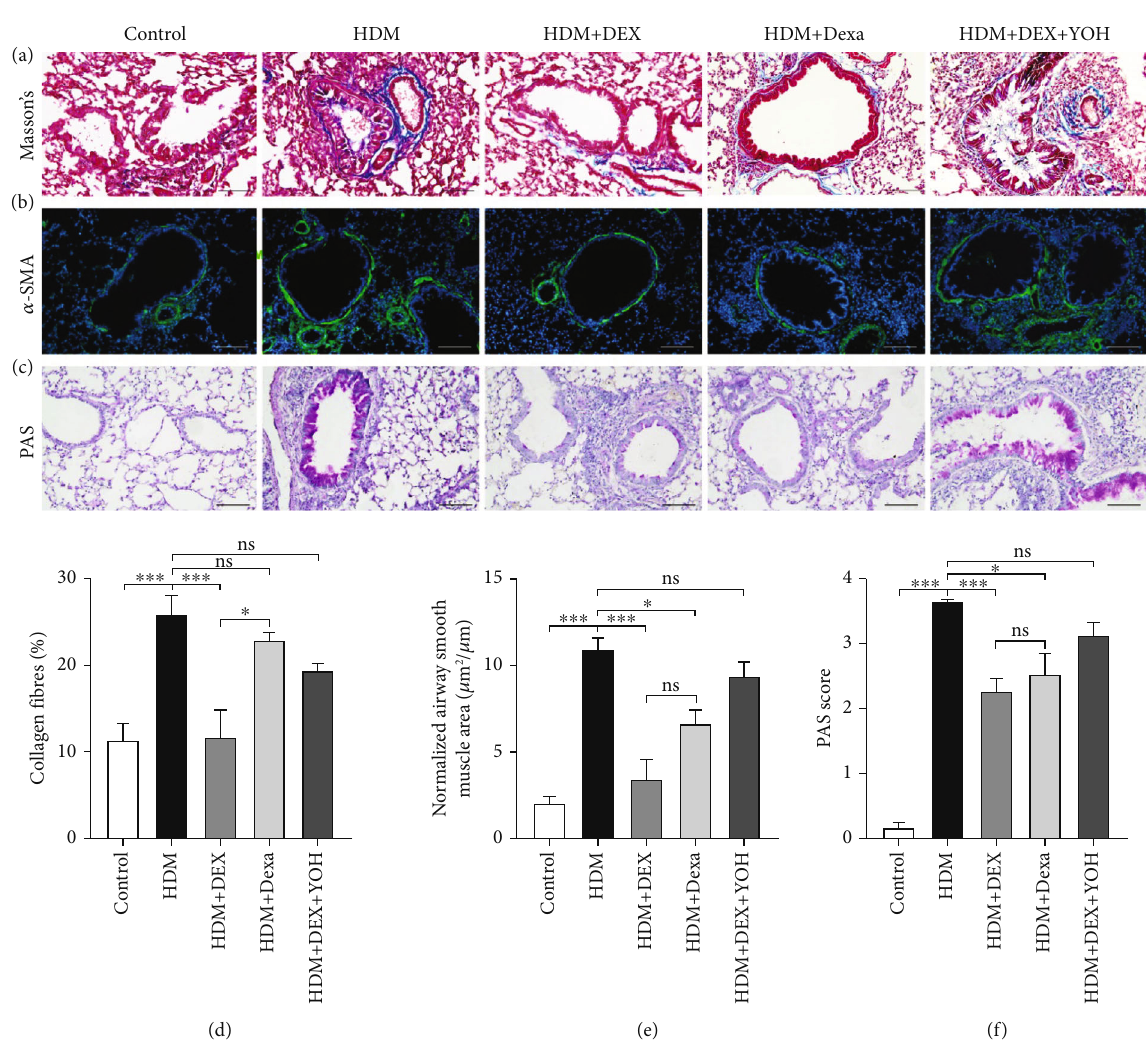
Figure 3: DEX administration inhibited airway remodeling in chronic asthmatic mice. Representative images of lung sections stained with Masson trichrome (a), anti- α -SMA antibody (green) (b), and PAS (c) from each group. Scale bar = 100 μ m. (d) Quantitative analyses of the percentage of collagen fi ber content in lung sections. (e) Quantitative analyses of positive α -SMA staining area, normalized to the perimeter of the basement membrane. (f) PAS score was calculated by the percentage of epithelium positive for PAS staining. Data were presented